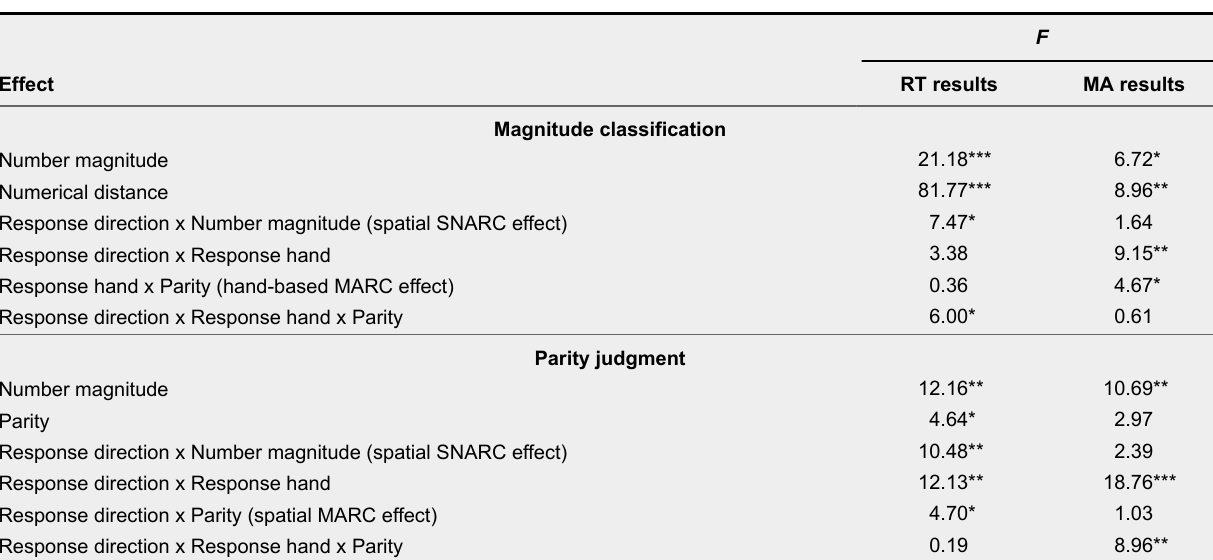
Summary of Significant Effects in Both